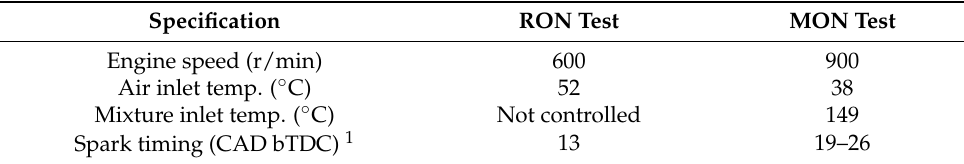
Table 1. Standard test conditions for RON and MON measurements from